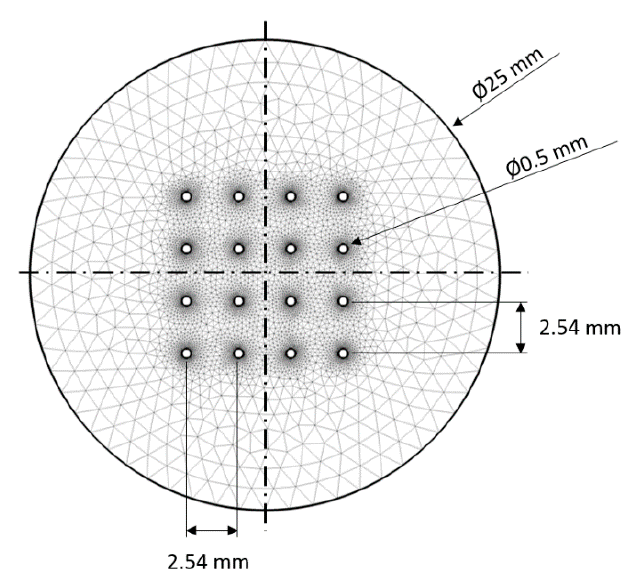
Figure 8. Generated FEM mesh and geometrical parameters of the 2D model. The electrode sites (small circles) are equidistant with 2.54 mm center-to-center spacing / pitch. Table 1. Physical and numerical model parameters (rutile titania particles and water fluid medium). Parameter Value